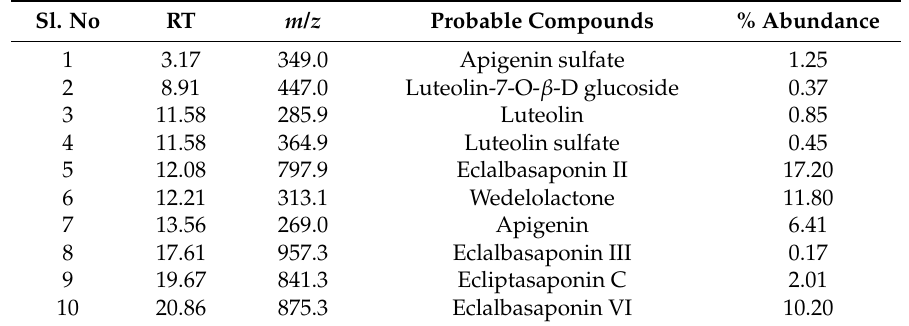
Table 5. Percent abundance of the compounds in the column purified methanol fraction of E.